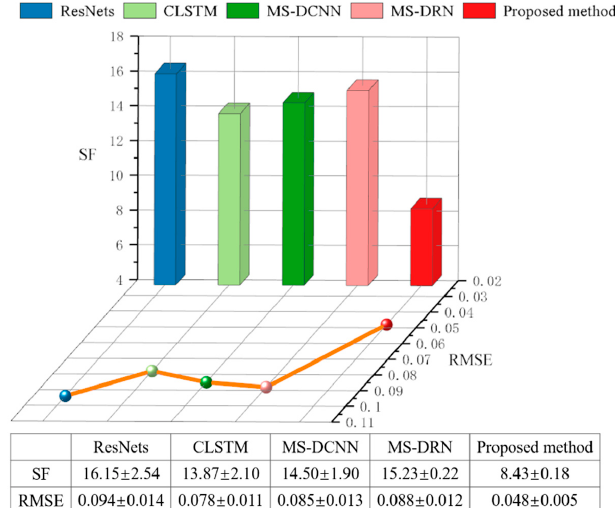
Figure 14. Evaluation indexes of different methods for the RUL prediction.